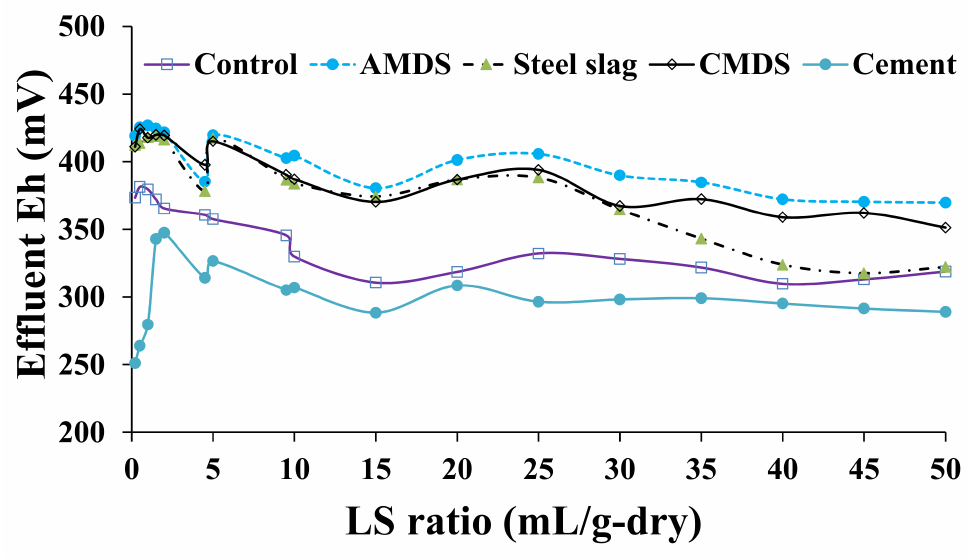
Figure 4. Eluate curves of the redox potential (Eh) as a function of L/S ratio in the column percolation test using different soil